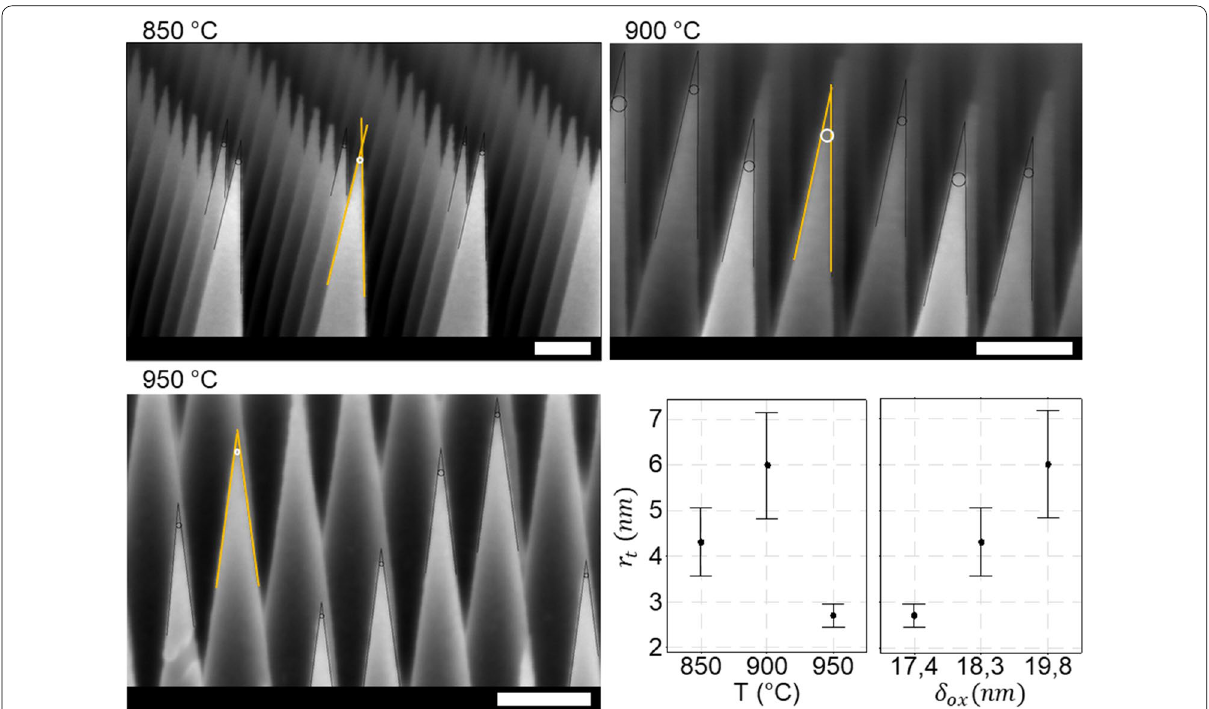
Fig. 6 SEM images of stripped SiNC tips were recorded for the different oxidation temperatures. The graphs in the bottom right show interval plots of the measured tip radii plotted against the different oxidation temperatures versus the oxide thickness measured on the flat dummy substrate. The CI is set at 95% with N 7. The scale bars represent 100 =